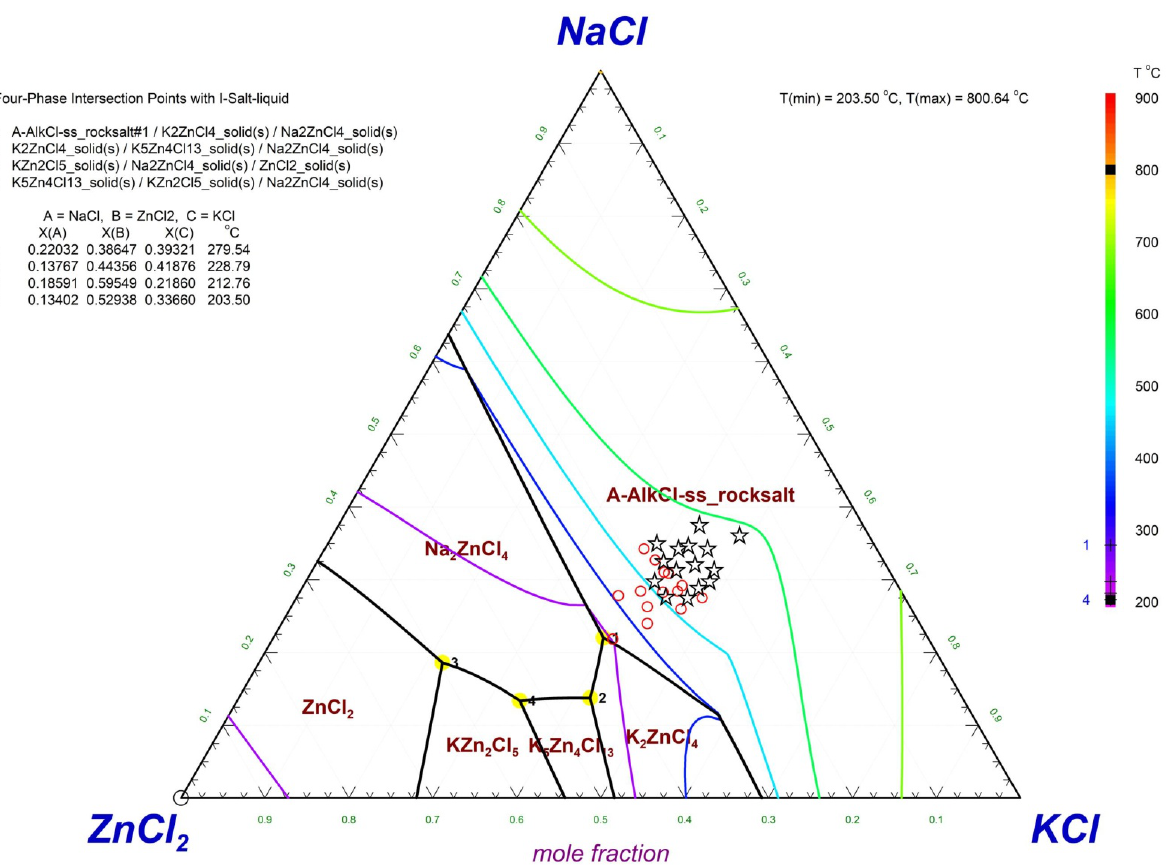
). Figure 10. Phase diagram of the KCl–NaCl–ZnCl 2 ternary system (case 1: ○ , case 2: Figure 10. Phase diagram of the KCl–NaCl–ZnCl 2 ternary system (case 1: Figure 10. Phase diagram of the KCl – NaCl – ZnCl 2 ternary system (case 1: ○ , case 2: ☆ ). ☆ As described in the results, the solid mixtures contained carbonates. Potassium As described in the results, the solid mixtures contained carbonates. bicarbonate and sodium carbonate hydrate (Na 2 CO 3 ∙mH 2 O, m = 1, 5, 7, 10) [40,41] have low melting temperatures (the endothermic peak near 160 °C in the DTA pattern matches